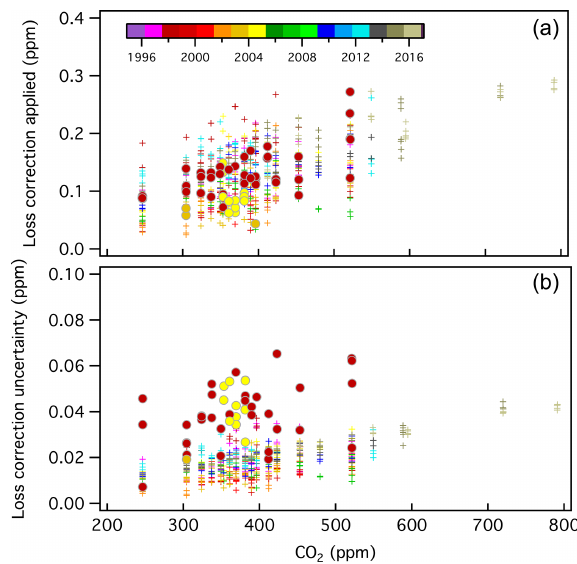
Figure 6. CO 2 loss correction ( X loss_correction ) applied to manome- ter results in developing the X2019 scale (a) and estimated un- certainty associated with the loss correction (b) , which have been color-coded by year (see Sect. S2.4). The corrections are mole frac- tion and time-dependent. Filled circles correspond to runs in which two CO 2 maxima were observed (1998 and 2004), and loss rates were determined from data after the second maximum. A total of 48 manometric runs were processed this way (8.9% of the